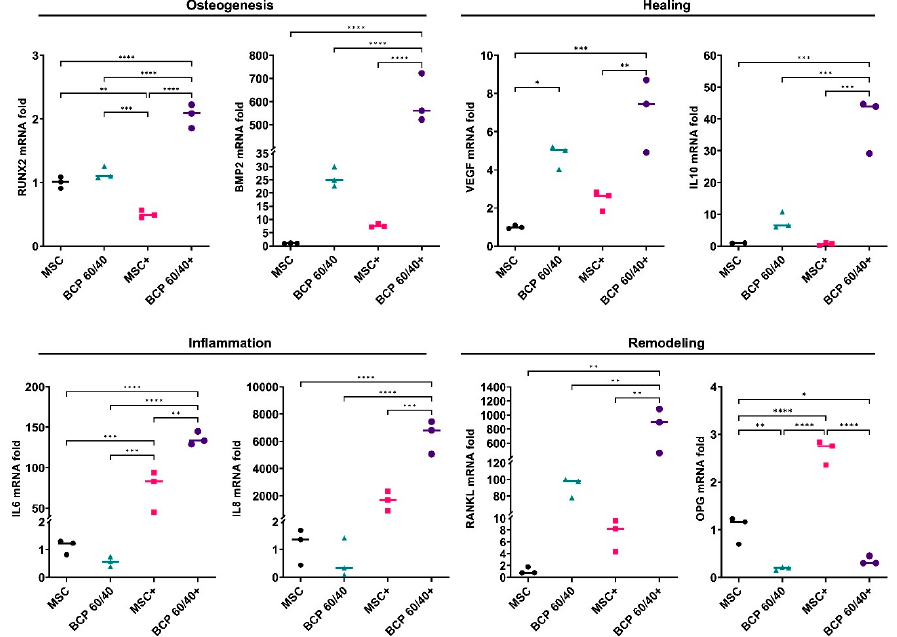
Figure 2. Relative mRNA expressions (fold changes) of osteogenesis-, healing-, inflammation- and remodeling-related genes in MSCs cultured as monolayers (control) or with BCP 60/40; + represents cytokine stimulation (n = 3). Statistical analyses are based on one-way ANOVA with Tukey’s multiple comparison tests on delta-Ct values; * p < 0.05; ** p < 0.001; *** p = 0.0001; **** p < 0.0001. A similar trend in MSC gene expression was observed in the presence of the BCP 20/80 granules : BMP2, VEGF, IL10 and RANKL were enhanced, in addition to OPG, com- pared to the control. In contrast to the BCP 60/40 culture, IL6 expression was enhanced in the presence of BCP 20/80. Under inflammatory conditions, the BCP 20/80 granules fur- ther enhanced the expressions of BMP2, IL10 and RANKL in the MSCs, along with those of the inflammation-related genes, i.e., IL6 and IL8 (Figure 3).